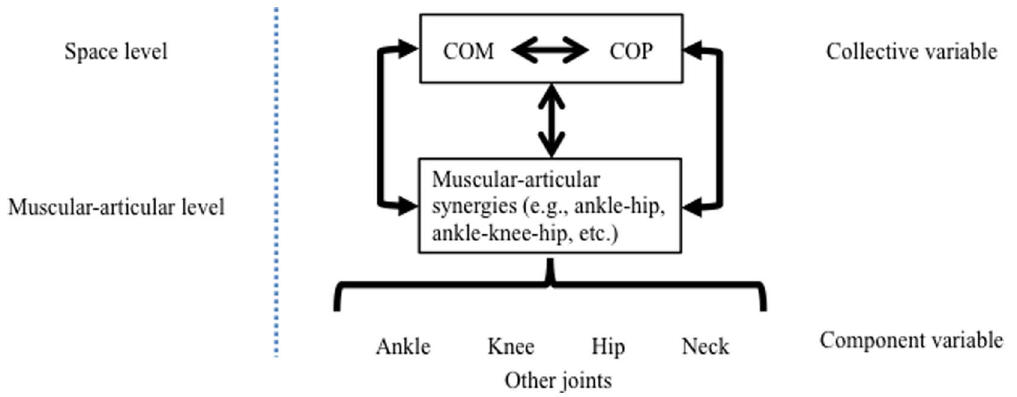
Figure 6. The circular causality for the self-organized postural control system.